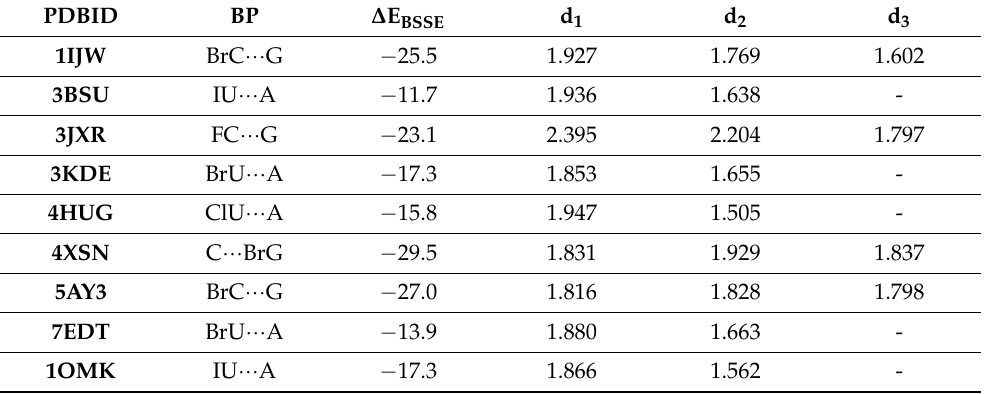
Table 5. List of selected PDB structures (PDBID), halogenated base pair combination (BP), BSSE corrected interaction energies ( ∆ E BSSE , in kcal/mol) and intermolecular distances (d 1 , d 2 and d 3 , in